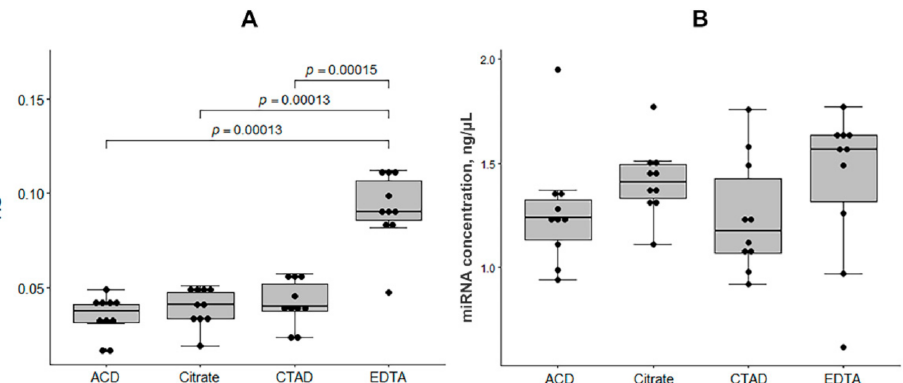
Figure 1. The distribution of biological sample characteristics in the study sample groups ( N = 40). ( A ) Hemolysis score (HS). ( B ) Concentration of miRNA, ng/ µ L. The boxplots represent median and interquartile ranges (IQRs) in the box and values for individual samples in the dots. The Mann- Whitney U test p -values corrected by false discovery rate are given for the statistically significant pairwise